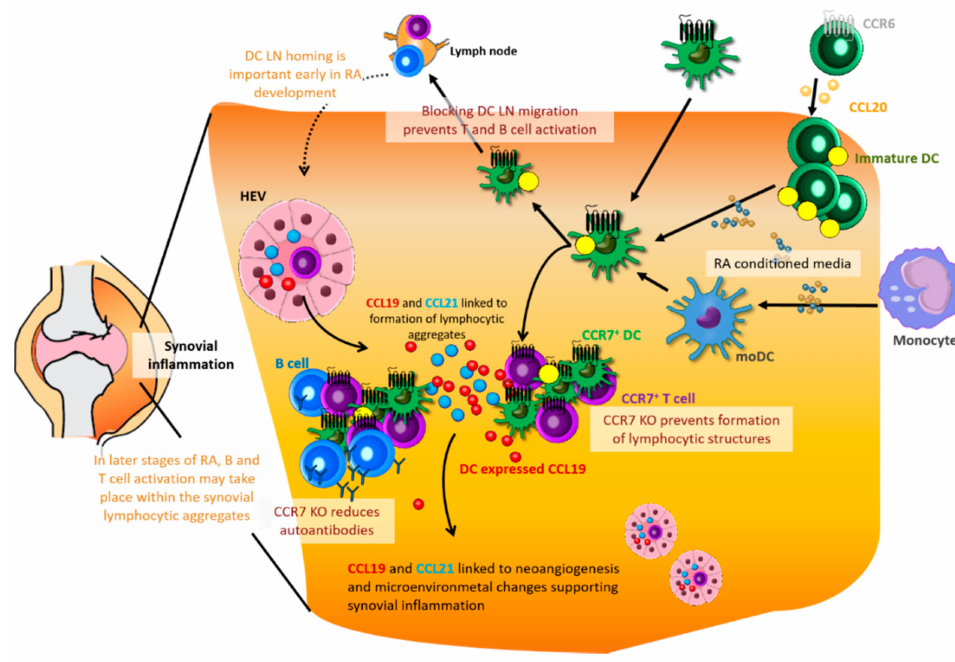
Figure 5. Dendritic cells (DCs) and the CCR7 axis in rheumatoid arthritis: DCs can be recruited into the joint but can also differentiate and mature from precursors or monocytes in response to locally produced cytokines. Blocking of the DC LN migration (by blocking MMP-9) prevents T- and B-cell activation, and displays protection against early RA in a mouse model. DCs from RA lesions can display increased CCL19 production and the presence of CCL21 and CCL19 chemokines are associated with the formation of lymphocytic aggregates both with and without B cells. These aggregates can support T- and B-cell activation in the later stages of RA. CCR7 KO protects against the formation of the lymphocytic aggregates in a mouse model and can also reduce the production of autoantibodies. CCL21 and CCL19 are also associated with microenvironmental changes, which can support the synovial